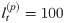
Heterogeneous search landscapes with representative trajectories of different strategies.Fragmented search landscapes containing Nt = 104 targets placed in Np = 10 heterogeneous patches (gray regions) with: (A) same average distance between inner targets, lt(p)=100, and radii uniformly distributed in the range 0.03M ≤ R(p) ≤ 0.3M, M = 104; (B) same radius, R(p) = 0.1M, and lt(p) uniformly distributed in the range 5≤lt(p)≤350; and (C) distinct sizes uniformly distributed in the range 0.03M ≤ R(p) ≤ 0.3M, but fixed number (103) of inner targets per patch, so that 17≤lt(p)≤170. The darker the patch, the higher its homogeneous density of inner targets. We also show typical paths of a searcher with power-law (Lévy-like) distributions of step lengths displaying different degrees of diffusivity: nearly ballistic (μ = 1.1), superdiffusive (μ = 2.0), and Brownian (μ = 3.0). In this illustrative example the search ends upon the finding of only 10 targets.